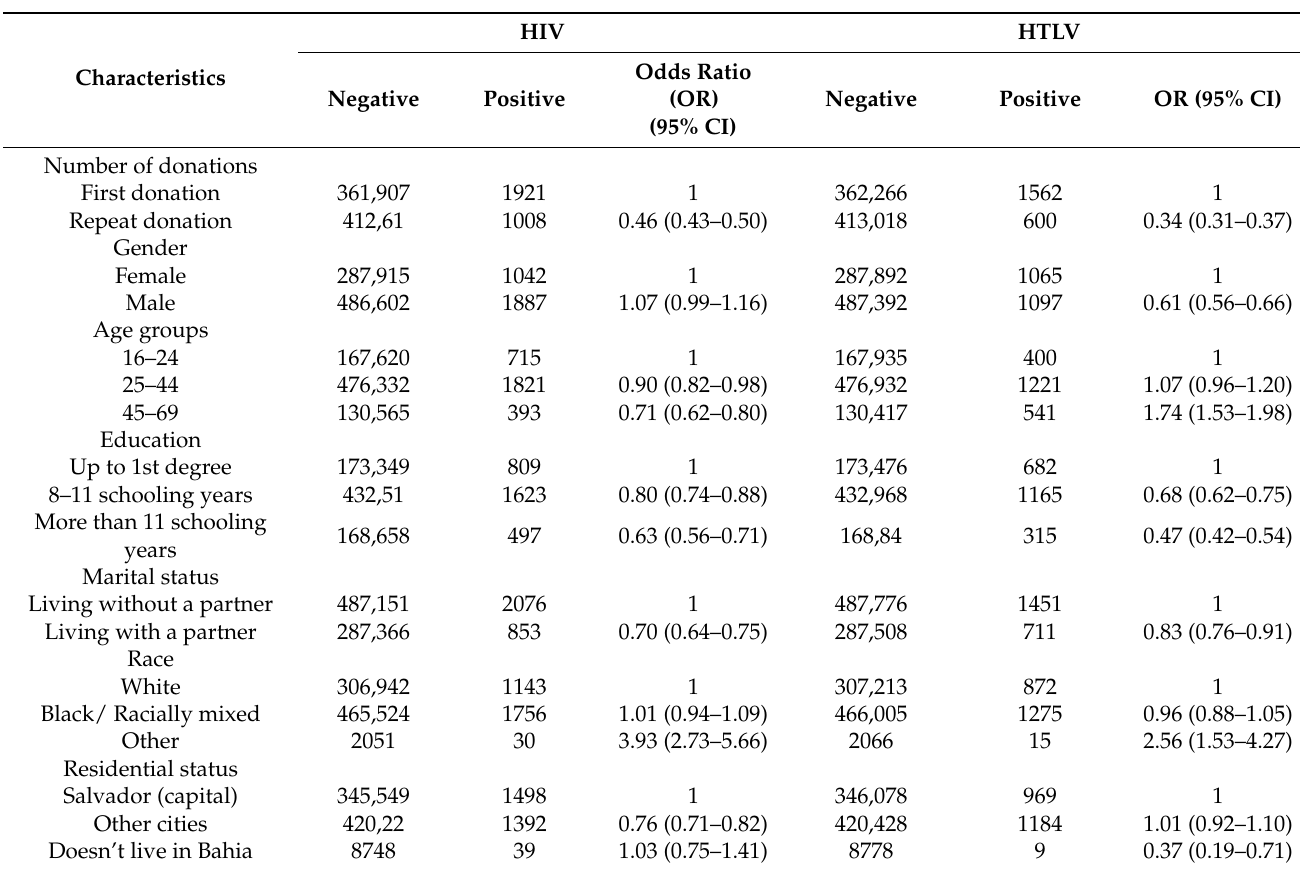
Table 4. Bivariate analysis of demographic characteristics associated with HIV and HTLV’s infections among Hemoba blood donors from February 2008 to December